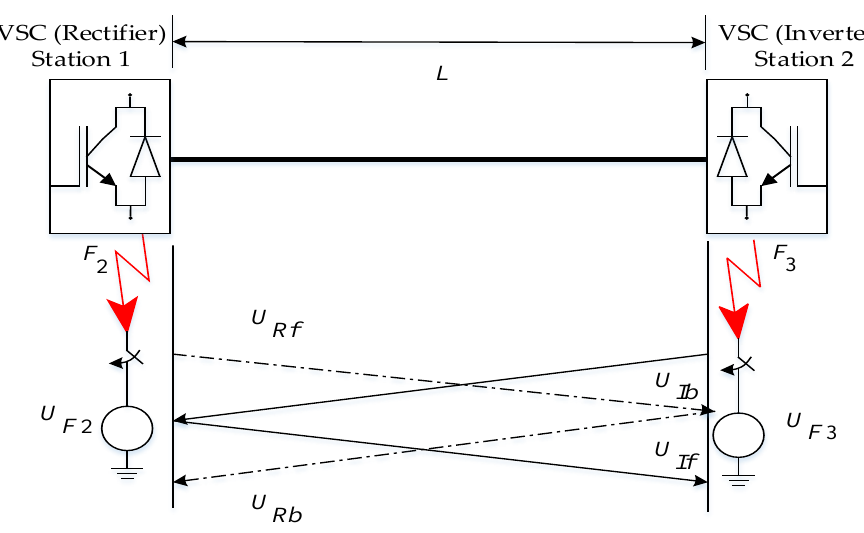
Figure 31. Propagation of traveling wave in case of external fault.